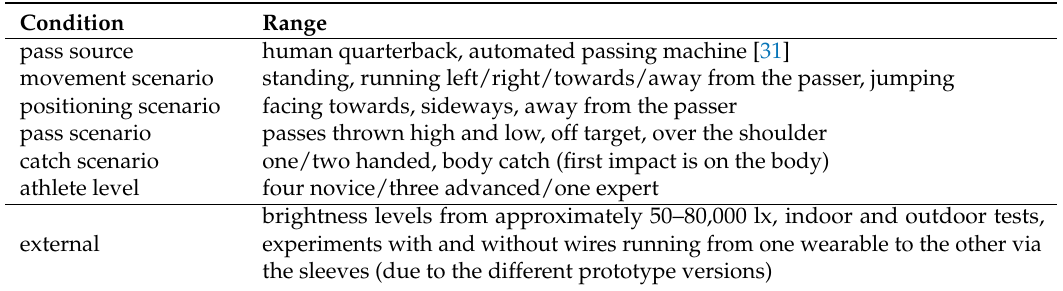
Table 2. Various conditions for the